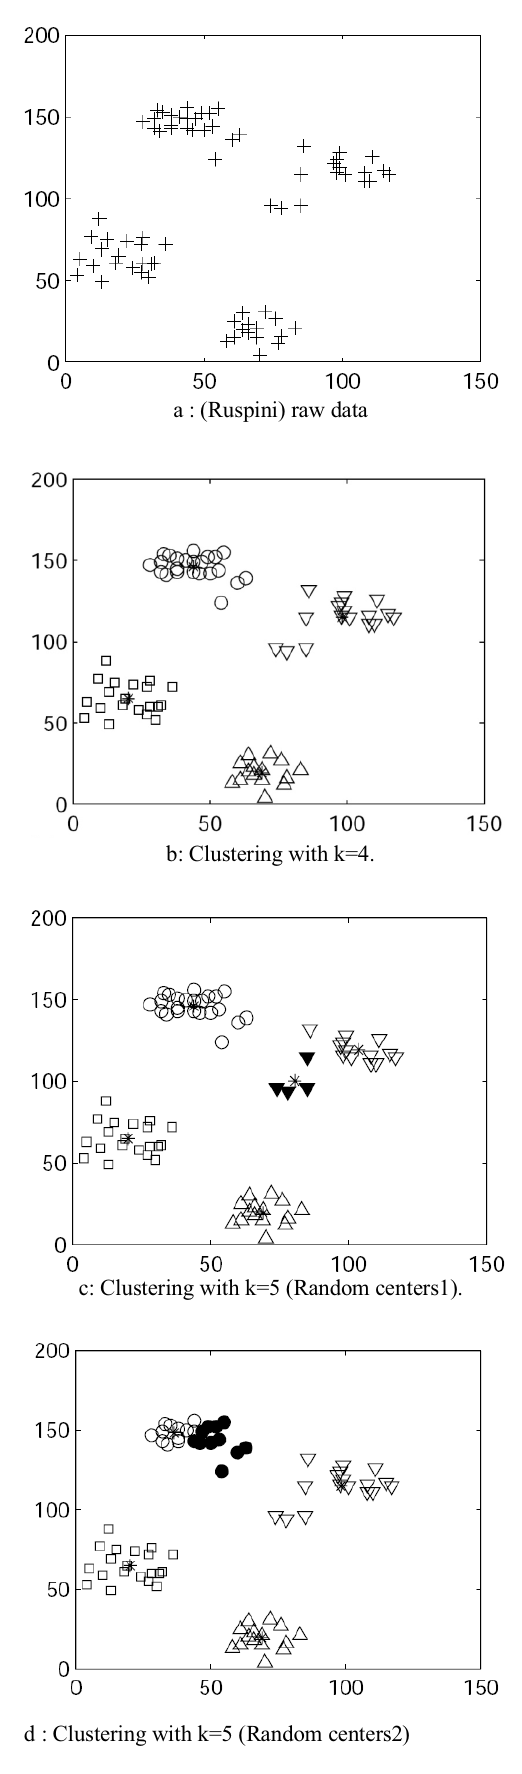
Fig. 5. The Ruspini dataset [8].